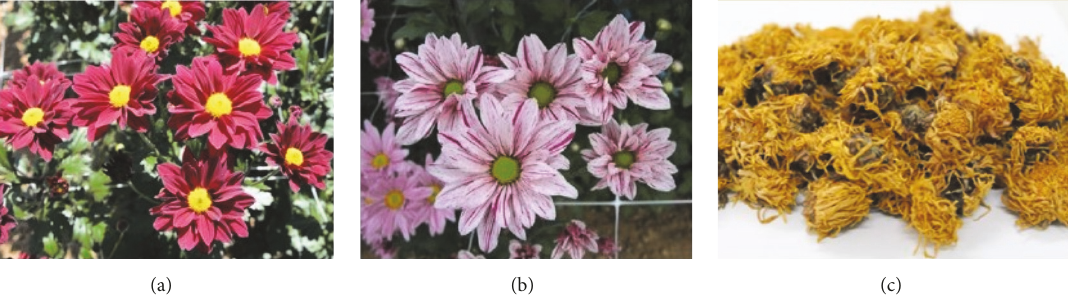
Figure 1: The flowers of (a) a radiation-induced mutant cultivar, C. morifolium cv. ARTI-Dark Chocolate (ADC); (b) the original cultivar, C. morifolium cv. Noble Wine (NW); (c) the commercially available medicinal herb, C . morifolium